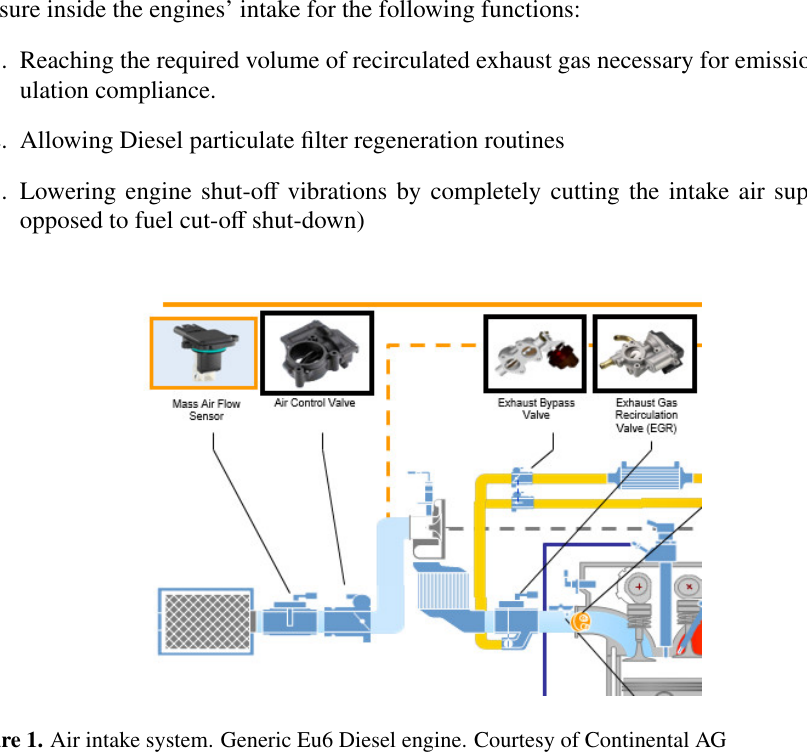
Figure 1. Air intake system. Generic Eu6 Diesel engine. Courtesy of Continental